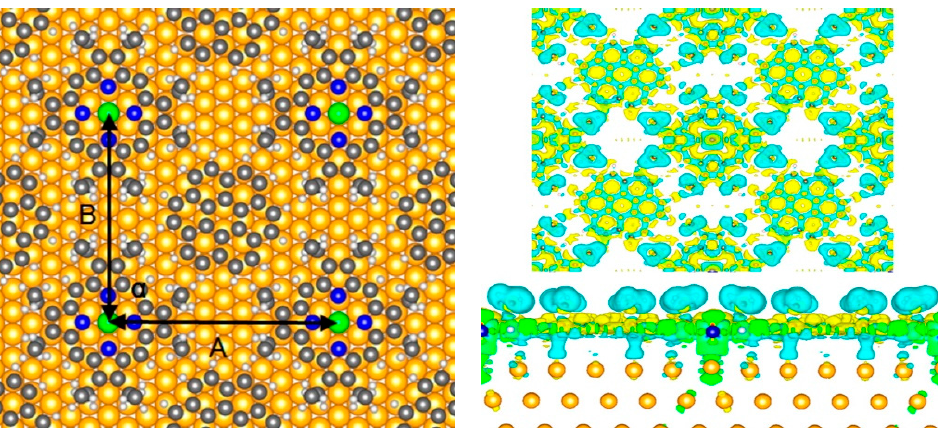
Figure 8. Model of coronene:CoOEP 1:1 structure (A) with corresponding surface charge distribution (B) obtained from PDFT simulations. Reprinted with permission from reference [109] Copyright 2015 American Chemical Society.